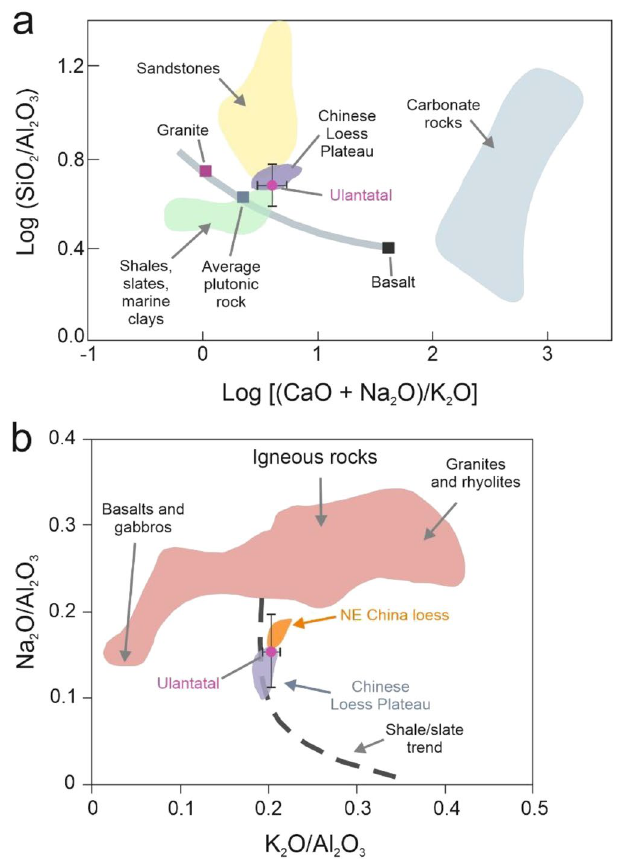
Figure 4. Compositional plots of Garrels and Mackenzie 64 . ( a ) Log [(CaO + Na 2 O)/K 2 O] versus Log (SiO 2 / Al 2 O 3 ) depicts the contribution of carbonates plus plagioclase to feldspar on x axis while the y axis is a measure of quartz to feldspars and clay minerals. Ulantatal sediments fall within the field of CLP loess 65–67 , which is expected since aeolian dust has particle size distribution dominated by silt-sized particles. ( b ) utilizes K 2 O/Al 2 O 3 versus Na 2 O/Al 2 O 3 as a measure of relative contributions from felsic versus mafic rocks in the x axis while the y axis depicts the relative contributions between igneous rocks and shale. Ulantatal sediments plot mainly to the CLP loess field 68 . The dot represents average composition and the error bars standard